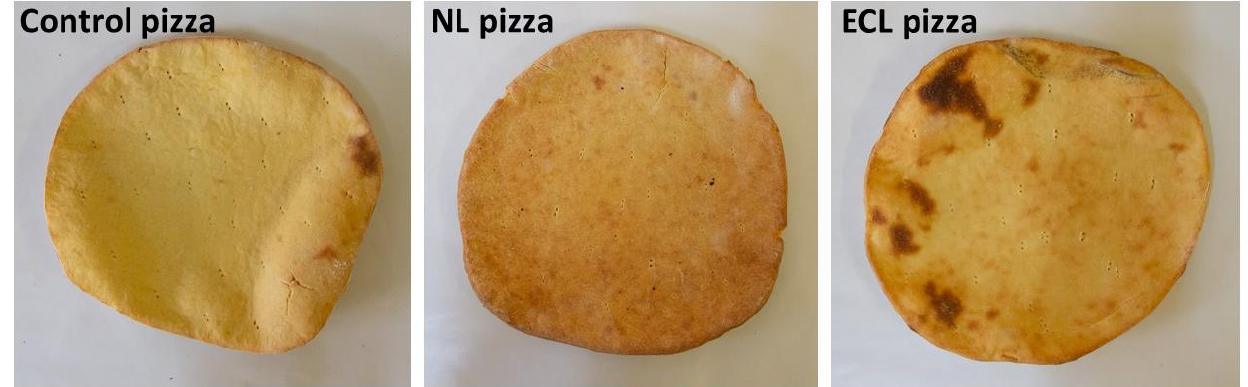
Figure 4. Visual appearance of experimental GF pizza samples. NL pizza = pizza crust enriched with native lentil flour; ECL pizza = pizza crust enriched with extruded-cooked lentil flour.